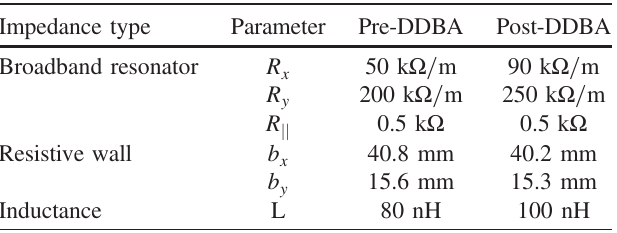
TABLE II. Comparison of single-bunch impedance model parameters before and after the installation of the DDBA